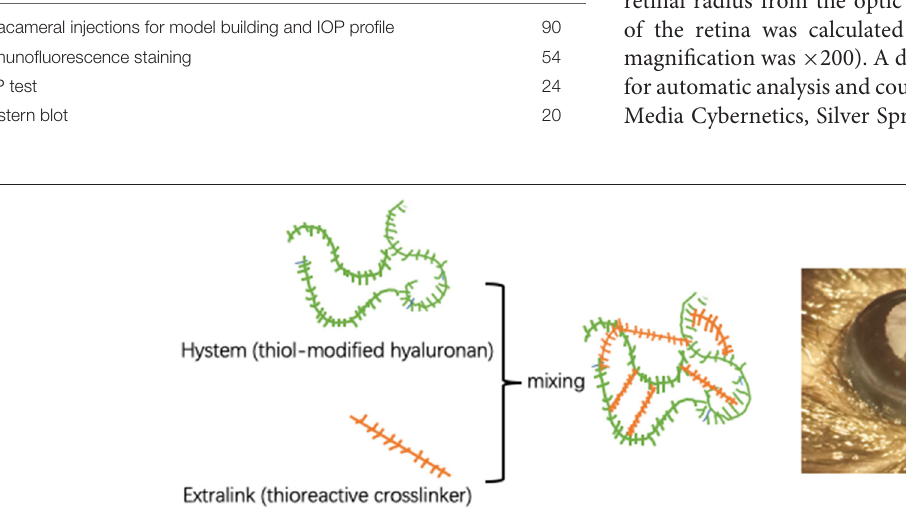
Frontiers in Medicine |